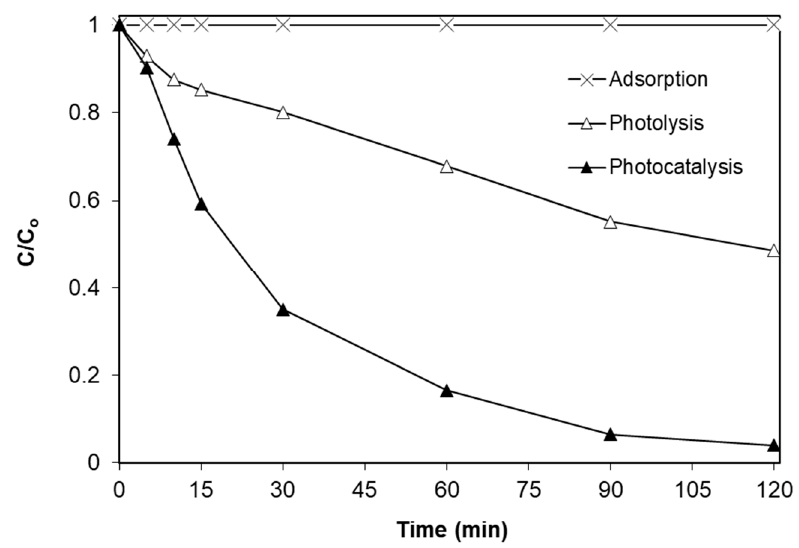
Figure 5. Adsorption, photolysis and photocatalytic degradation of SMX in UPW. [SMX] = 234 μ g/L, [0.04%Fe/TiO 2 ] = 1 g/L and natural pH.